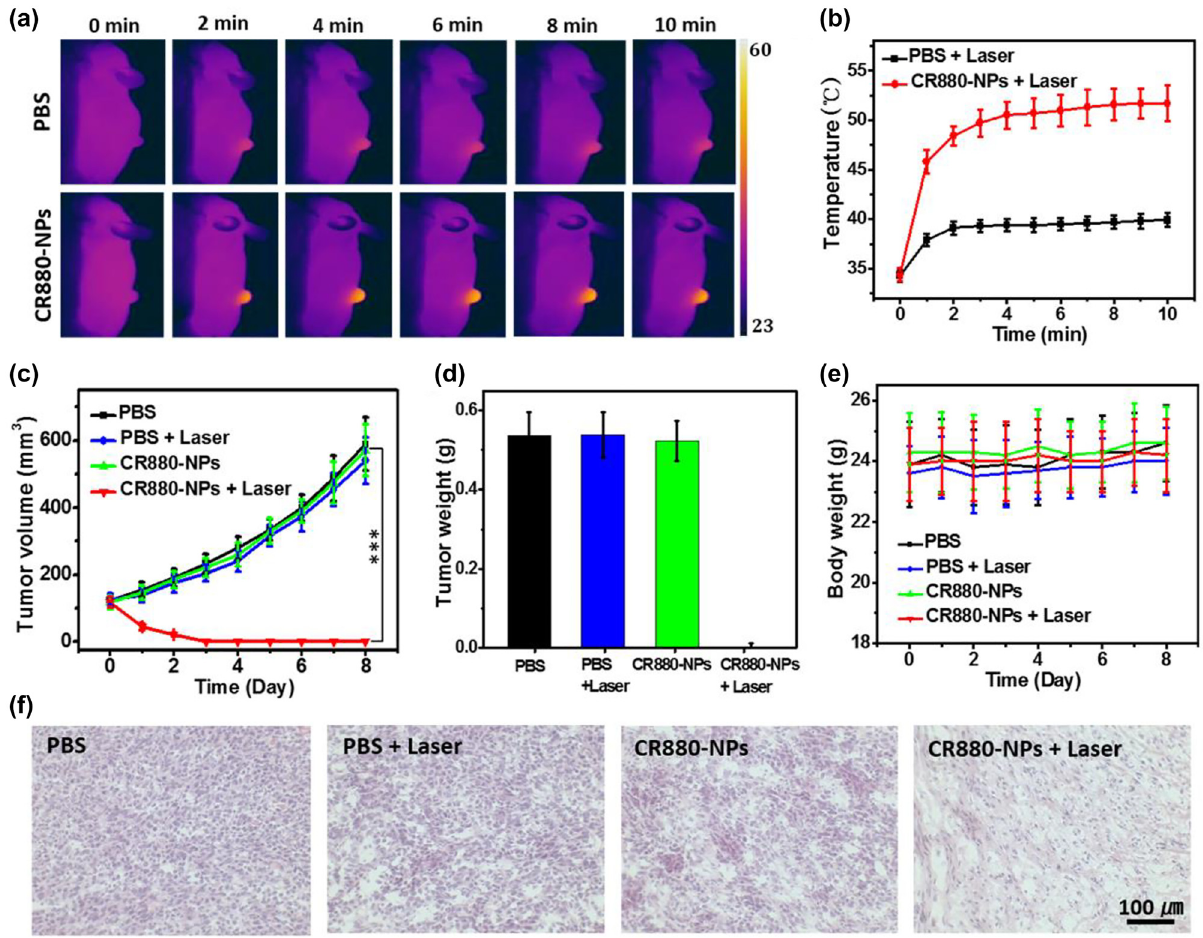
Figure 5: Photothermal effect of CR880-NPs in vivo . (a) Thermal images of 4T1 tumor-bearing mice after indicated treatments under laser irradiation (885 nm CW laser, 0.8 W/cm 2 ). (b) The temperature changes of tumors recorded at different time points as shown in (a). (c–e) Relative tumor volumes, tumor weight, and body weight of mice having received different treatments. (f) H & E stained images of tumors resected from the different treatment groups at day 8. ( ∗∗∗ P < 0.001).